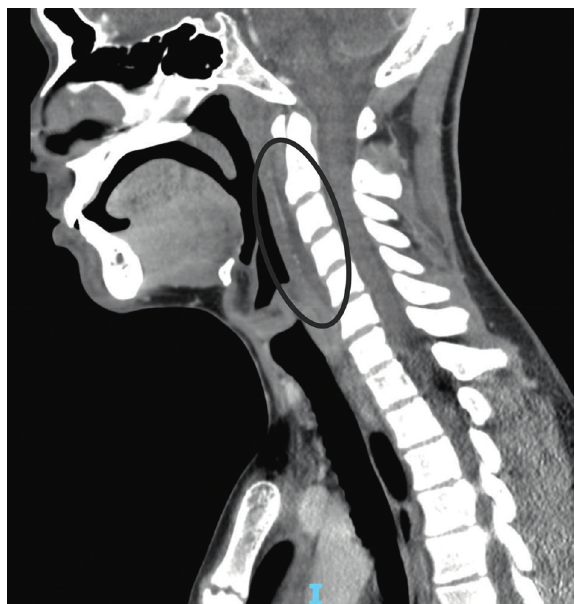
Figure 1: Palatine tonsillar enlargement and a retropharyngeal fluid density extending from the palatine tonsil down to C7/T1.